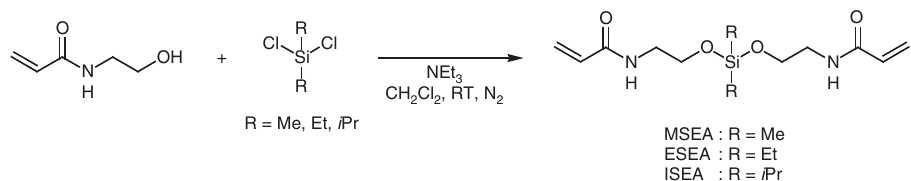
Fig. 1 Synthesis of acrylamide-based crosslinkers with labile silyl ether linkage in a one-step synthesis. Crosslinkers with methyl (MSEA), ethyl (ESEA) or isopropyl (ISEA) as substituents on the silicon atom were